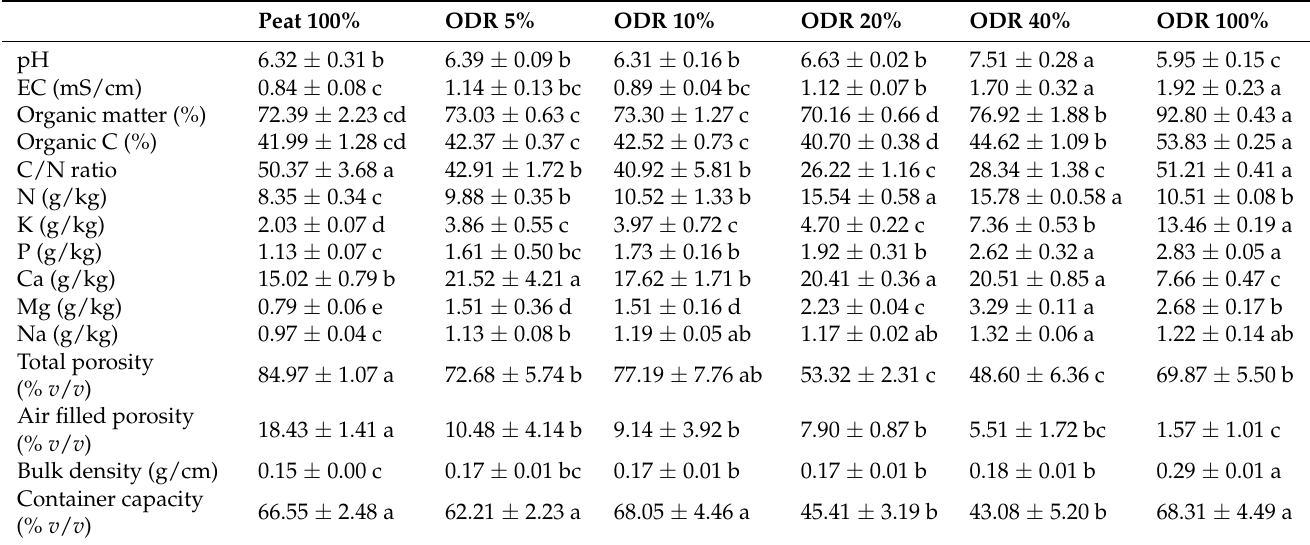
Table 1. Growing media (peat and Origanum dubium Boiss. residue (ODR)), showing its physicochem- ical properties before plant transplantation.